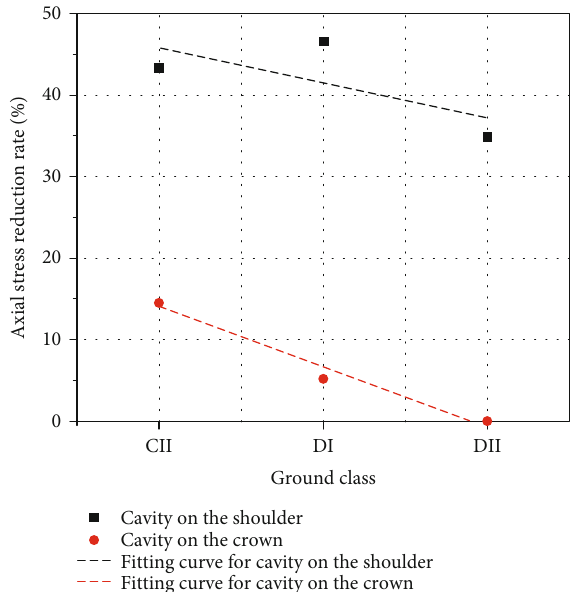
Figure 17: The axial stress reduction rate on lining concrete for tunnels with a